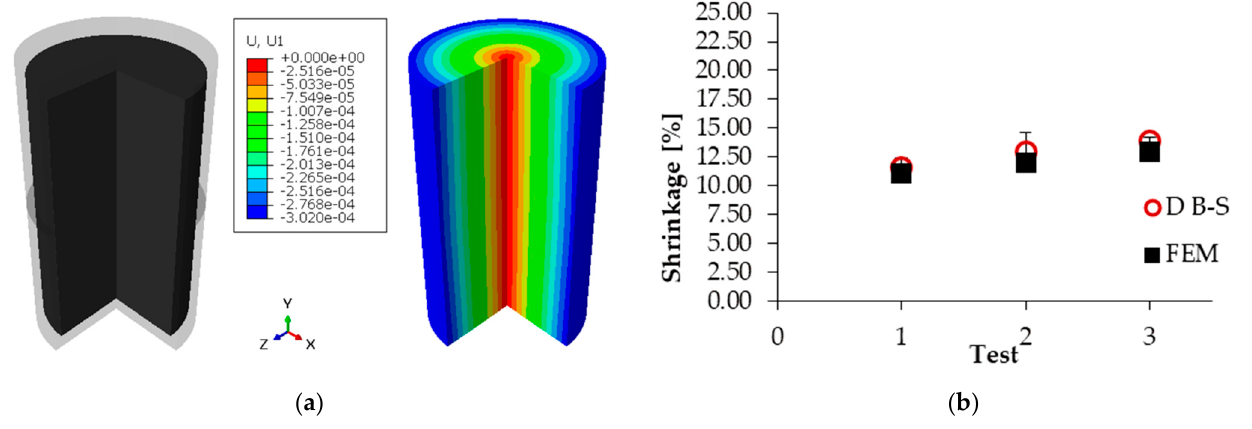
Figure 12. ( a ) After sintering shape vs. translucent presintered shape (left) and predicted radial displacement (right). ( b ) Experimental shrinkage vs. FEM simulations.